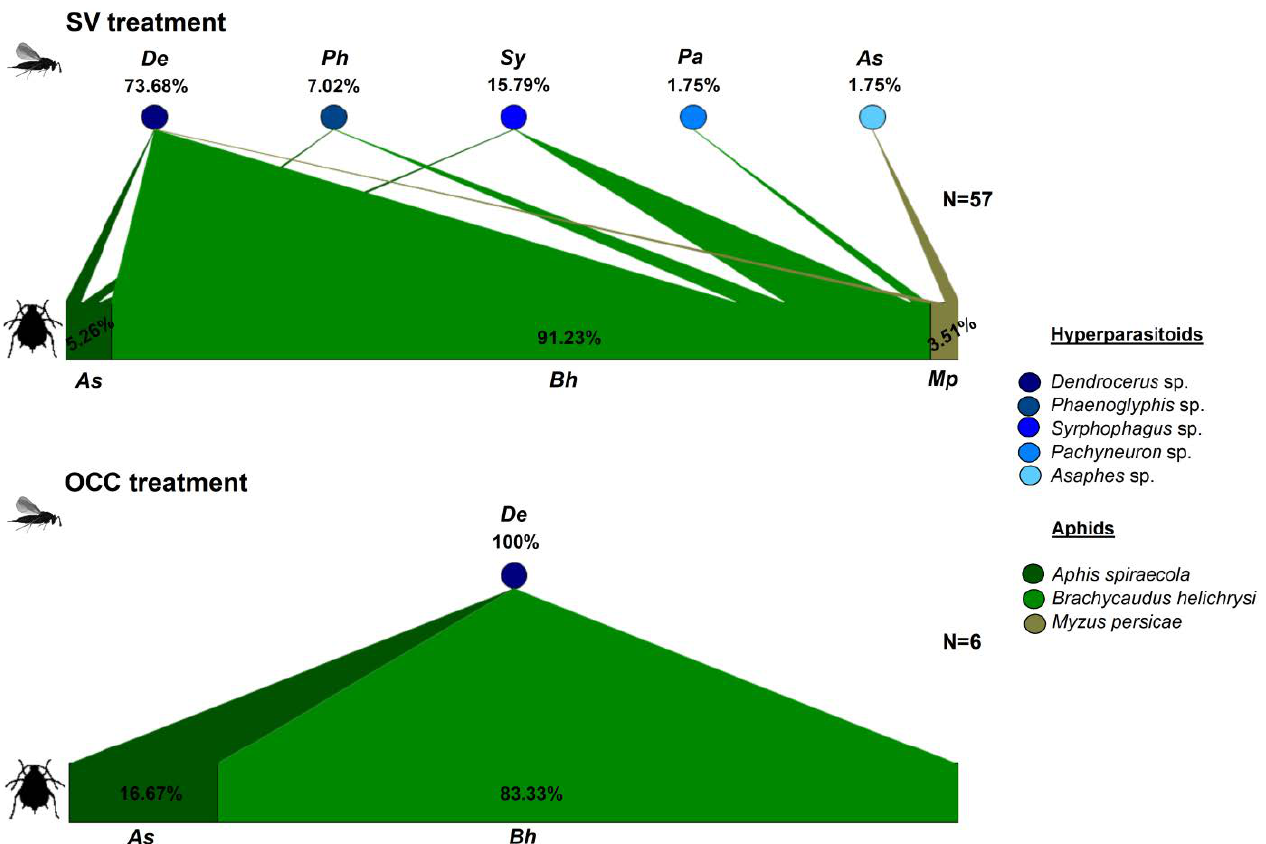
Figure 2. Quantitative food webs of aphids – hyperparasitoids (secondary parasitoids) during spring in plum orchards in Chile comparing two treatments: Spontaneous vegetation (SV) and oat cover crop (OCC). The horizontal bars represent the relative abundances of each aphid species parasitized with hyperparasitoid emergence ( lower bars) and the hyperparasitoids ( upper circles). The arrows represent the strength of interaction (% relative abundances) between each aphid host – hyperparasitoid combination. N = corresponds to the number of adult parasitoids emerged in all samples (unparasitized aphids were not considered).